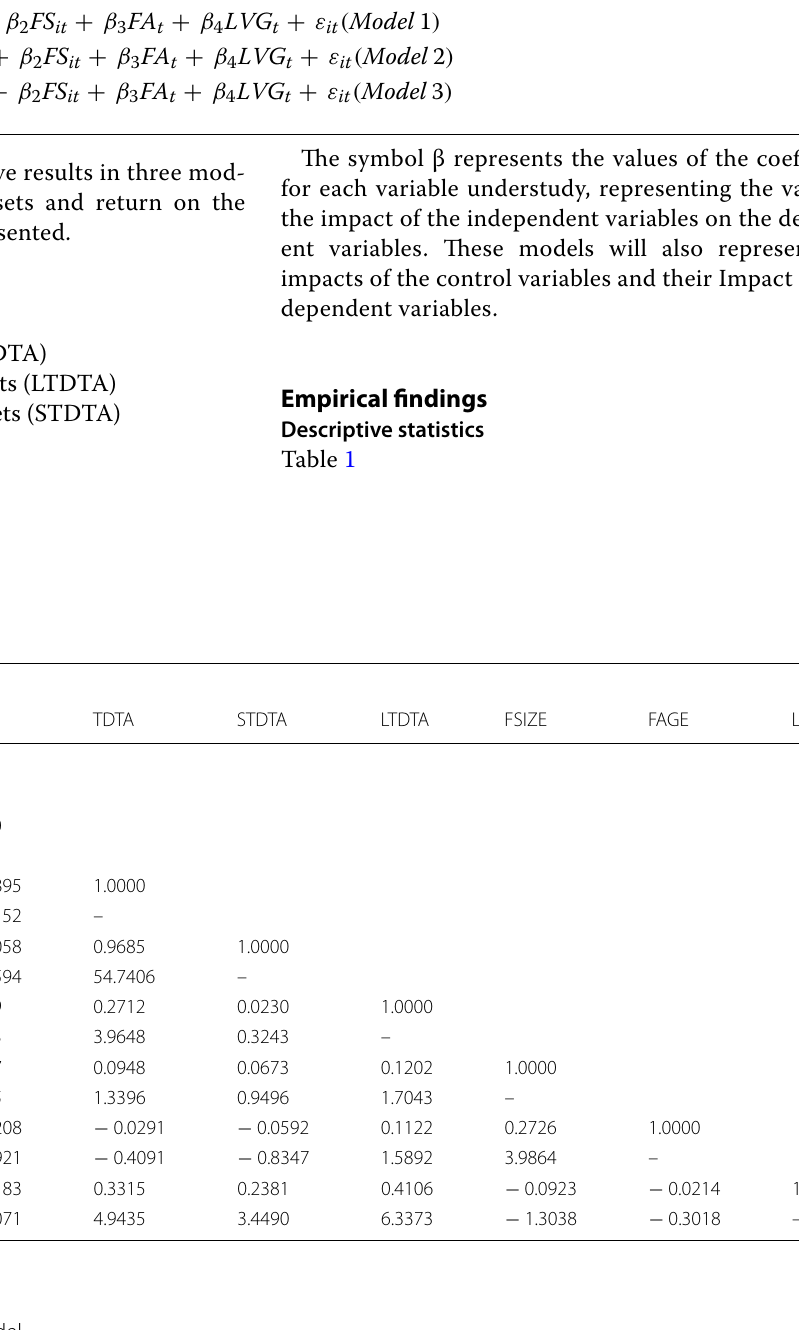
Table 3 Diagnostics test for ROA model